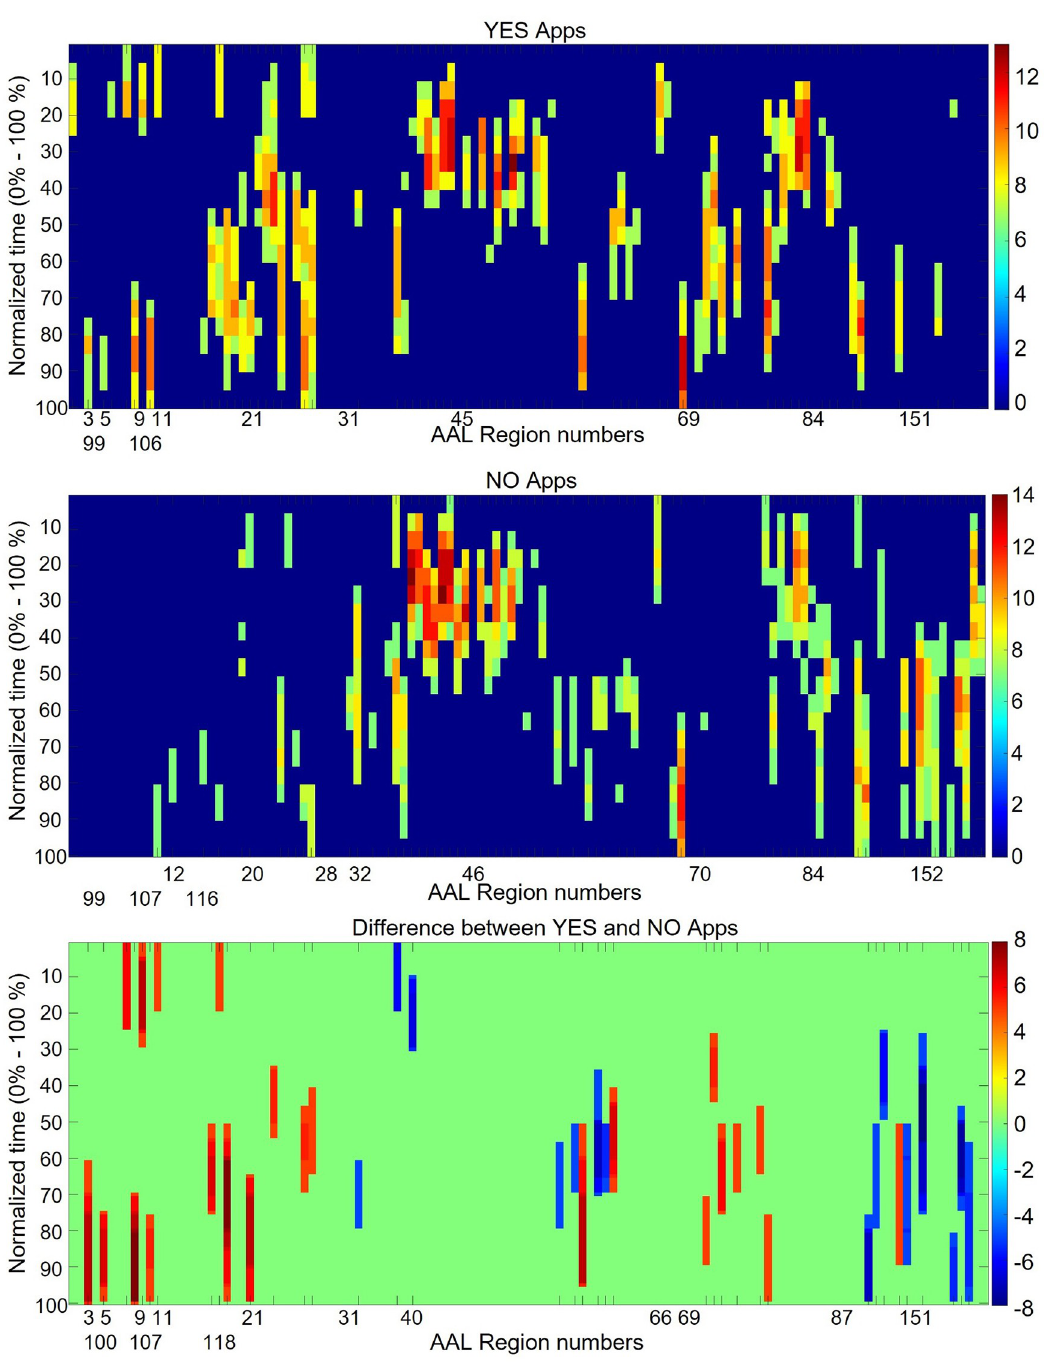
Fig 9. (top–middle) Spatiotemporal plots for only YES (top) or NO (middle) response to the apps. The axis is flipped w.r.t the plot in Fig 5 while keeping the same color coding. (bottom) The spatiotemporal difference plot indicating the difference between the ROIs which shows significant difference in response between YES and NO apps. The red lines indicate ROIs more active in YES apps while the blue lines indicate the ROIs more active in NO apps.